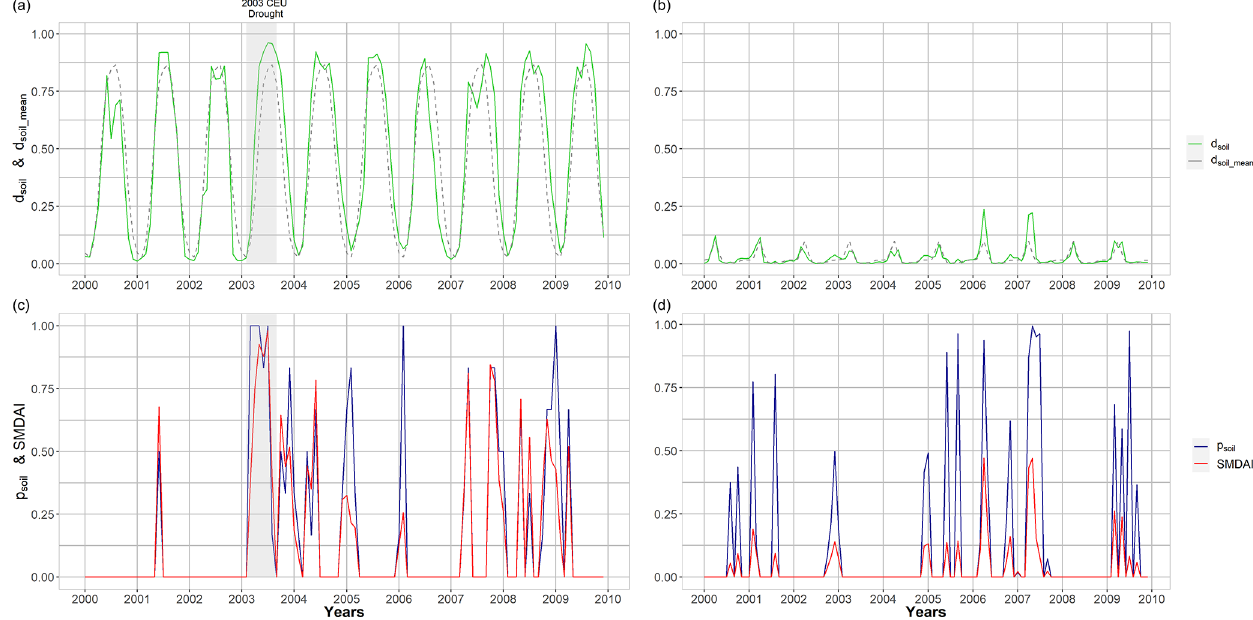
Figure 1. Soil moisture drought hazard: example of a time series (2000–2010) of monthly d soil and mean seasonality of soil moisture deficit, p soil and SMDAI for a cell in Germany (a, c) and a cell in northeast India (b, d) . The central European (CEU) drought in 2003 is indicated.